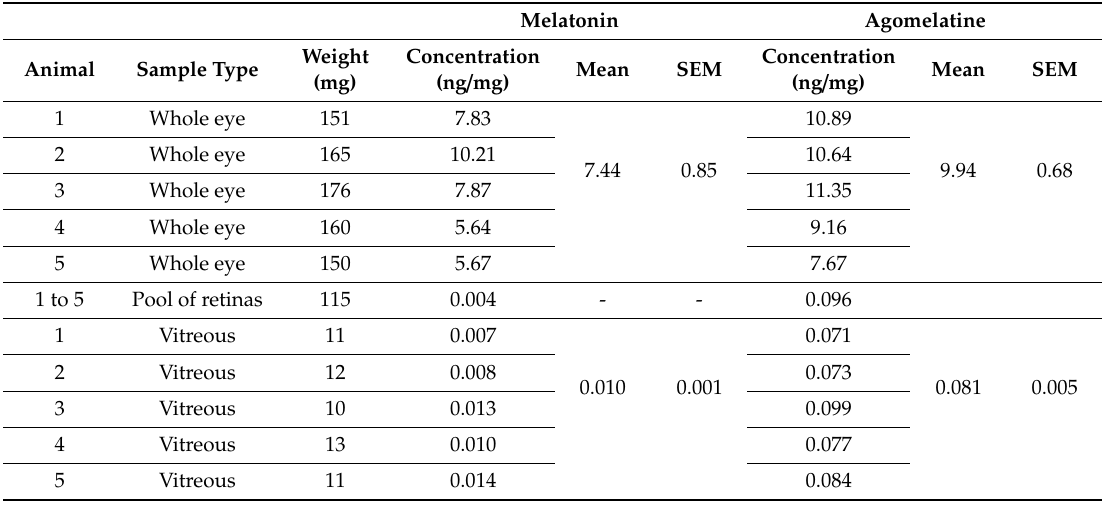
Table 1. Concentration of melatoninergic compounds in the whole eye, the retina, and the vitreous. Melatonin Agomelatine